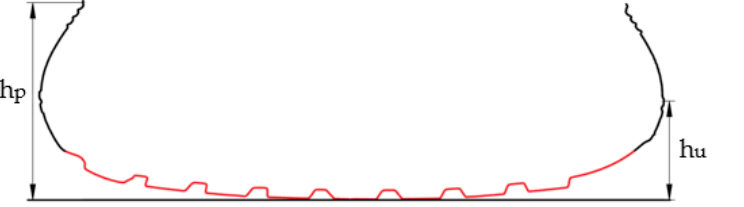
Figure 2. Vertical cross-section of the tire profile: h p – total height of the profile, h u —height measured at the maximum vertical deformation.